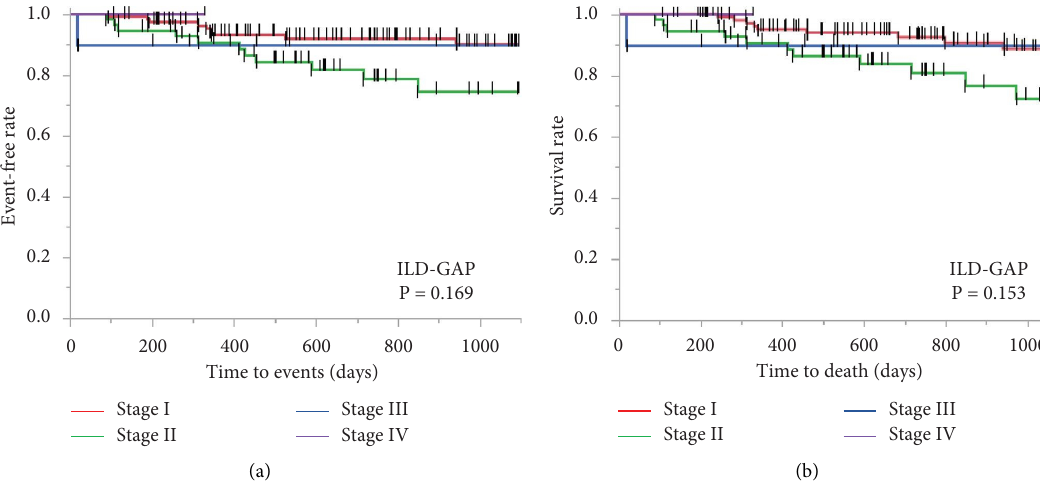
Figure 2: Kaplan − Meier curves according to the ILD-GAP classifcation. Te enrolled ILD patients were divided into 4 stages according to the ILD-GAP classifcation (stage I, 117 cases; stage II, 57 cases; stage III, 10 cases; stage IV, 1 case). Te Kaplan − Meier curves for predicting 3-year ILD related events (a) or 3-year all-cause mortality (b) proved to be not signifcant between 4 stages. ILD, interstitial lung disease; G/A/P, gender/age/physiology. Table 3: Univariate analysis of primary predictors of 3-year ILD-related events.